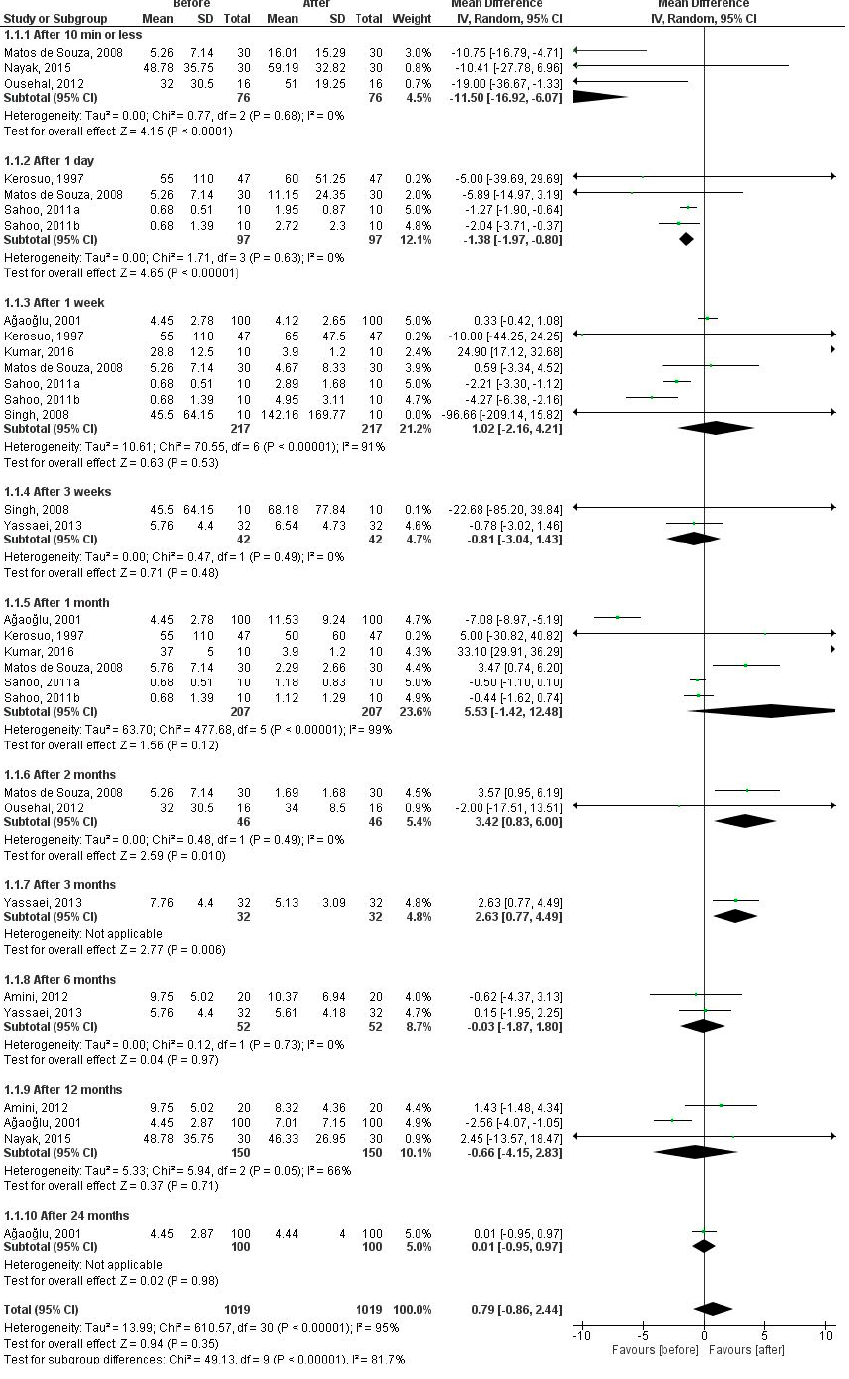
Figure 2. Forest plot of the random effect of salivary nickel levels in patients under fixed orthodontic treatment (before versus after treatment).